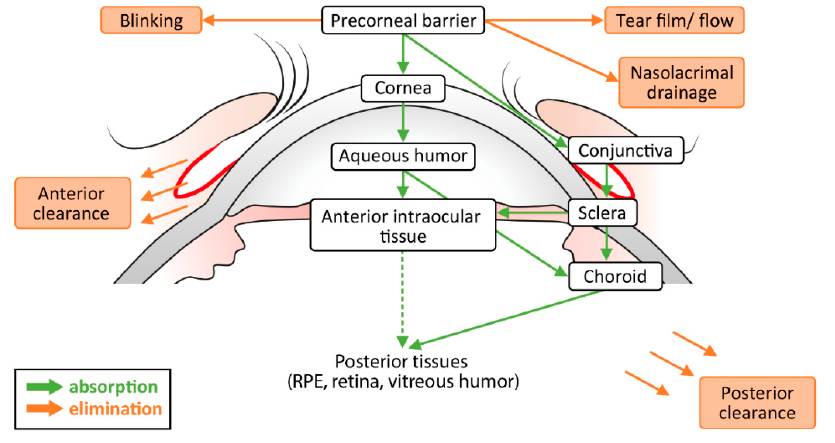
Figure 1. Schematic overview of drug absorption and elimination after topical application.